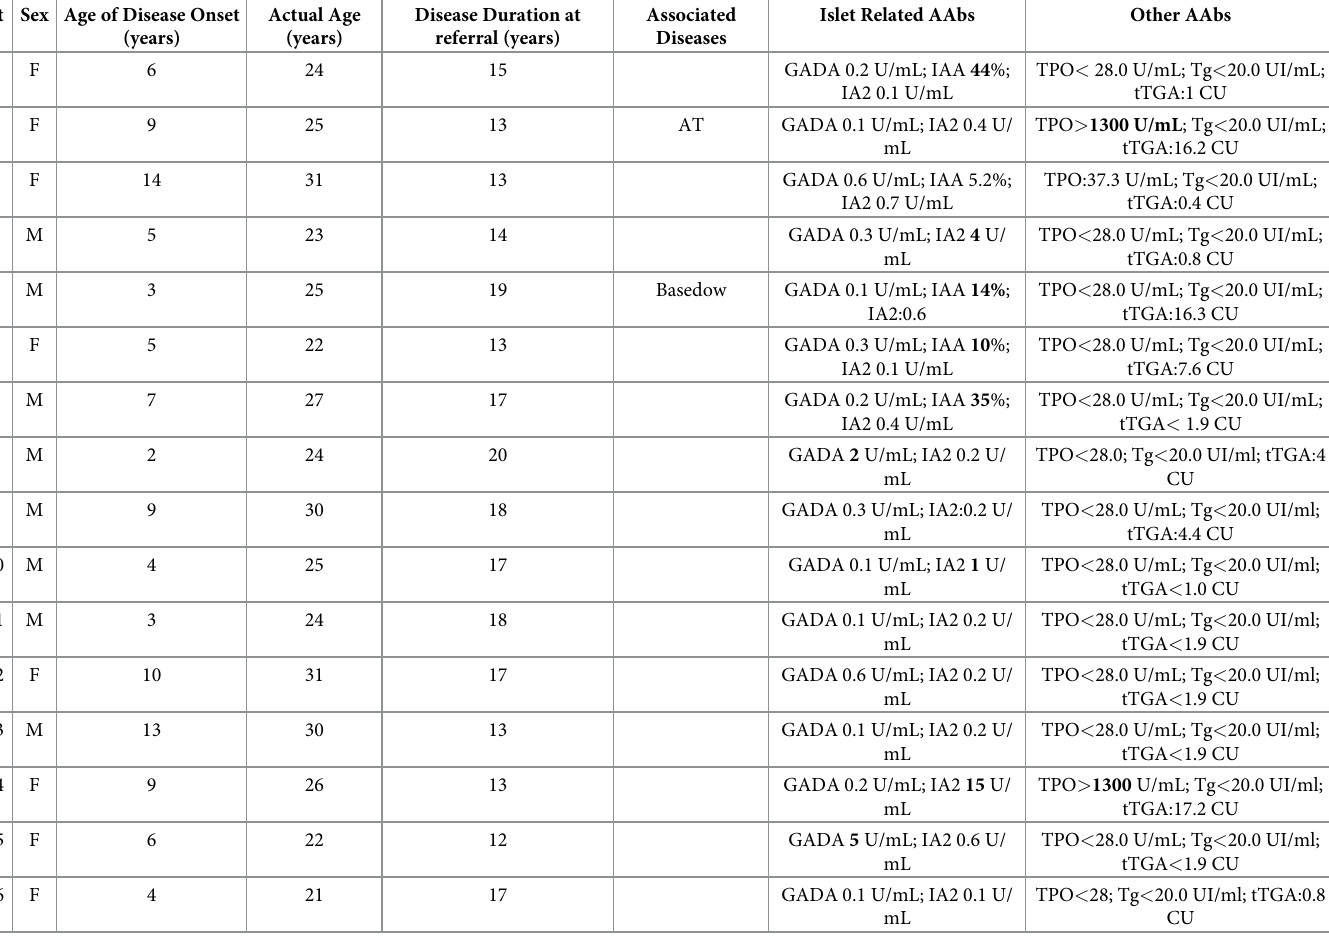
Table 1. Demographic and clinical characteristics and autoantibody levels of the LT type 1 diabetes patients recruited for the study. Pt Sex Age of Disease Onset